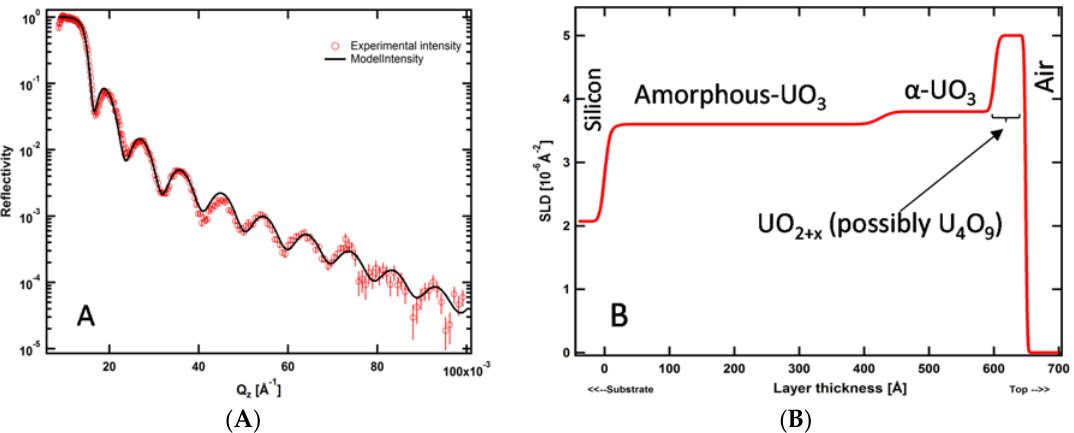
Figure 7. ( A ) NR data obtained from a UO x deposited on a silicon substrate (open circles). Error bars indicate one standard deviation. The solid line through the data points corresponds to the best ‐ fit SLD profile shown in ( B ).